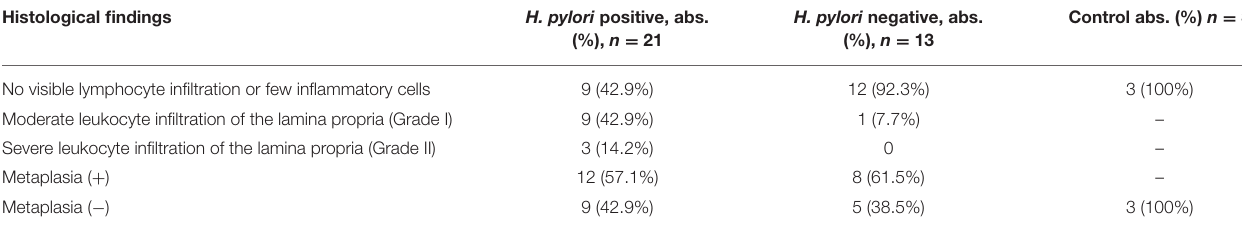
TABLE 1 | Histological examination of the gastric biopsies from H. pylori positive and negative gastroduodenitis cases. Histological findings H. pylori positive, abs.